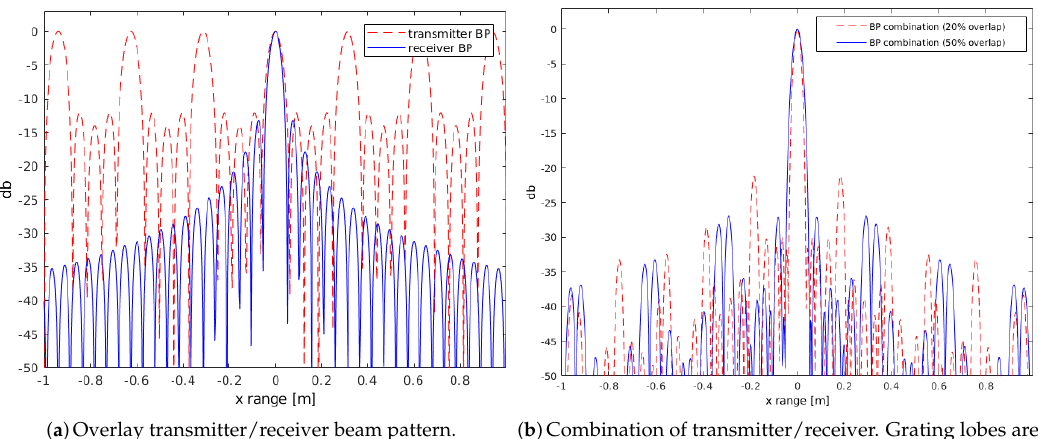
Figure 7. Theoretical beam pattern of uniform linear arrays. Comparison of grating lobes using different distances between sub-apertures. Parameters are according to the example with four array positions (Section